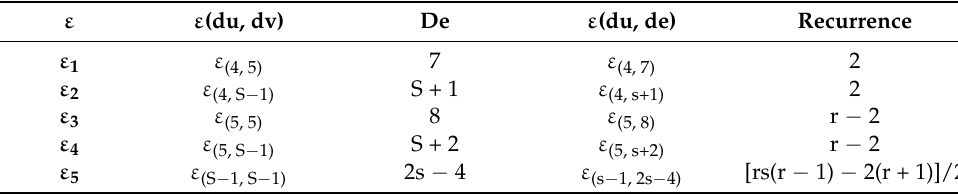
Table 4. Edge partition of G r (C s, v ) over C s .